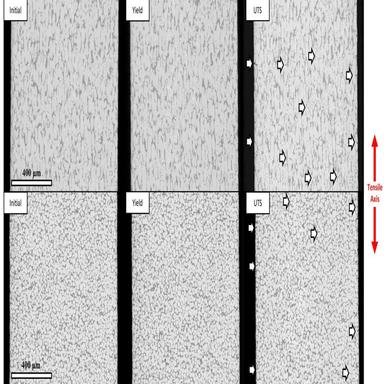
Sequential SEM backscattered electron images from in-situ mechanical test of R87 RD-TD (top) and AR (bottom) specimens displayed before the test (initial), at the yield point, and then at the UTS. Multiple microcracks have been noted using white arrows. For interpretation of the references to color in this figure legend, the reader is referred to the web version of this article.